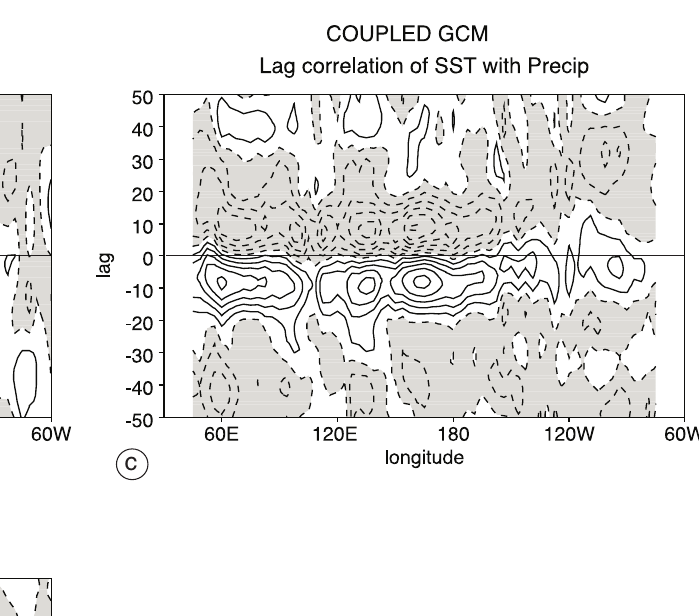
Fig. 9a-c. Lag correlations between precipitation at every longitude and an index of MJO activity at 90 ° E, based on the 20-100 day filtered 200 hPa velocity potential, from: a) a version of the coupled ocean- atmosphere model, HadCM3, and b) the equivalent atmosphere-only model, HadAM3. c) Shows the simulated lag correlations between the precipi- tation and SST at every longitude (as in fig. 7a) from HadCM3. From Inness et al.